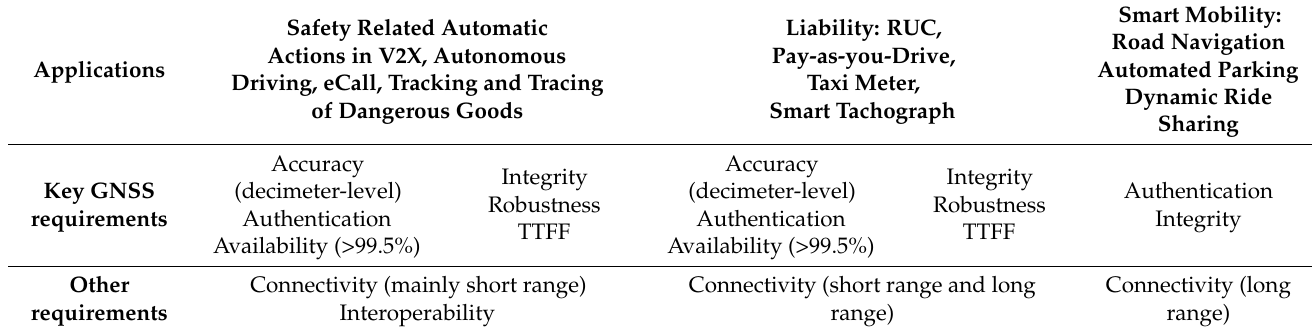
Table 2. High priority requirements for the road transportation domain.